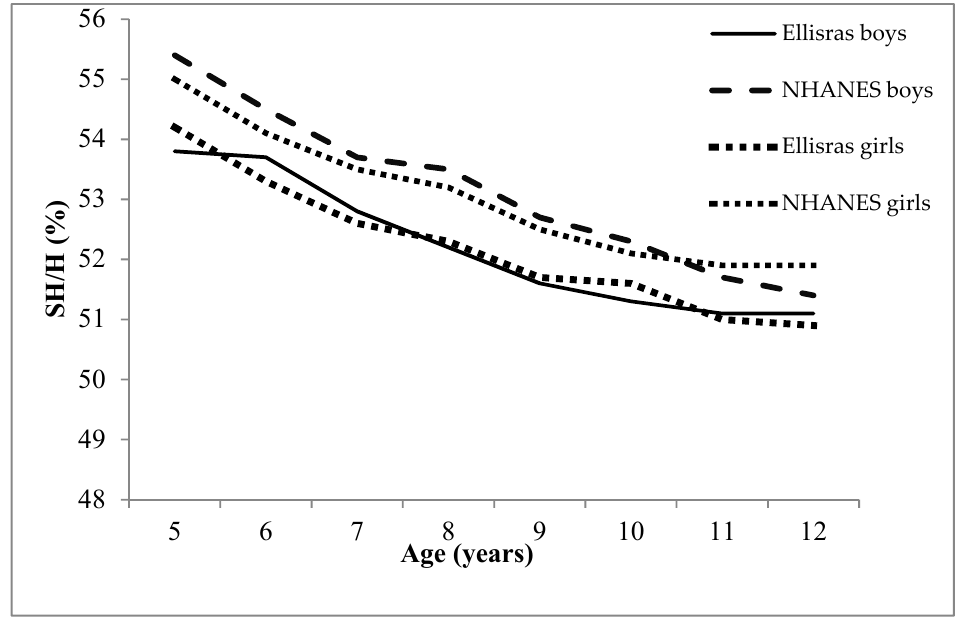
Figure 2. The comparison of SH/H in Ellisras and National Health and Nutrition Examination Survey (NHANES) children aged 5–12 years.